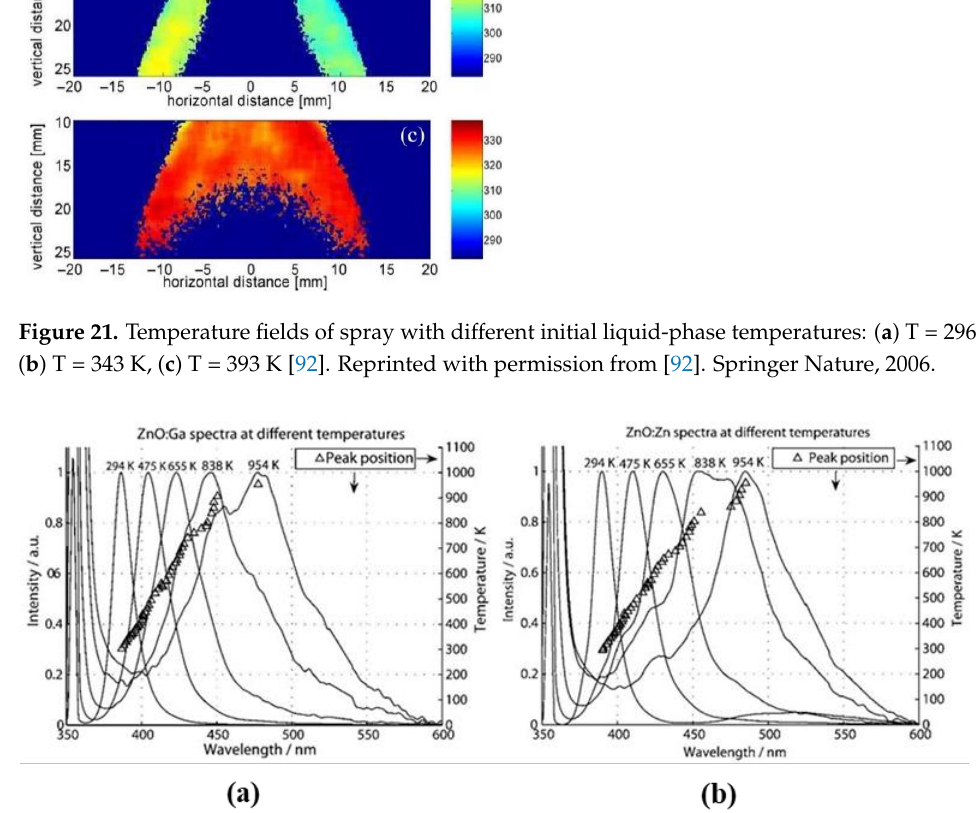
Figure 22. Normalized spectra of ( a ) ZnO:Ga and ( b ) ZnO:Zn. The position of the emission peak is plotted on the right axis as a function of temperature [96]. Reprinted with permission from [96]. Optica Publishing Group, 2008.